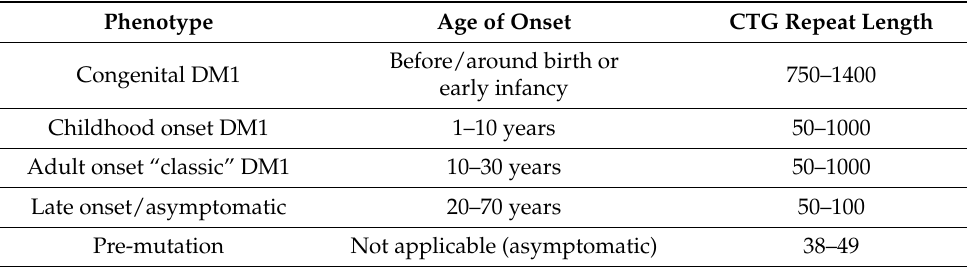
Table 3. Correlation of CTG repeat size and clinical subtype of DM1